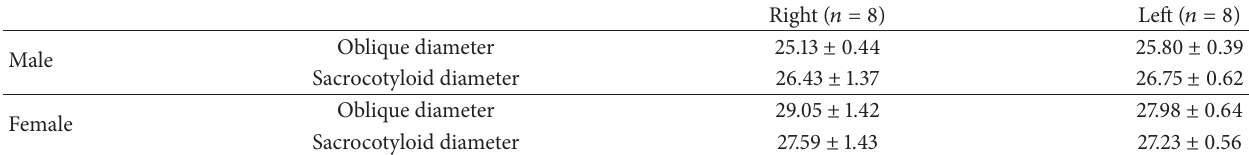
Table 2: Statistical comparison of biometric measurements belonging to left and right sides of pelvic cavity obtained as a result of 3D reconstruction (mm ±